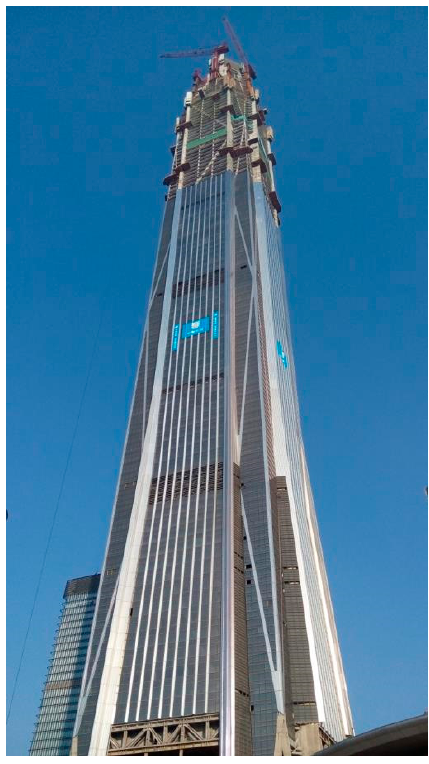
Figure 12. Ping An Finance Center during construction (Source: Wikipedia).